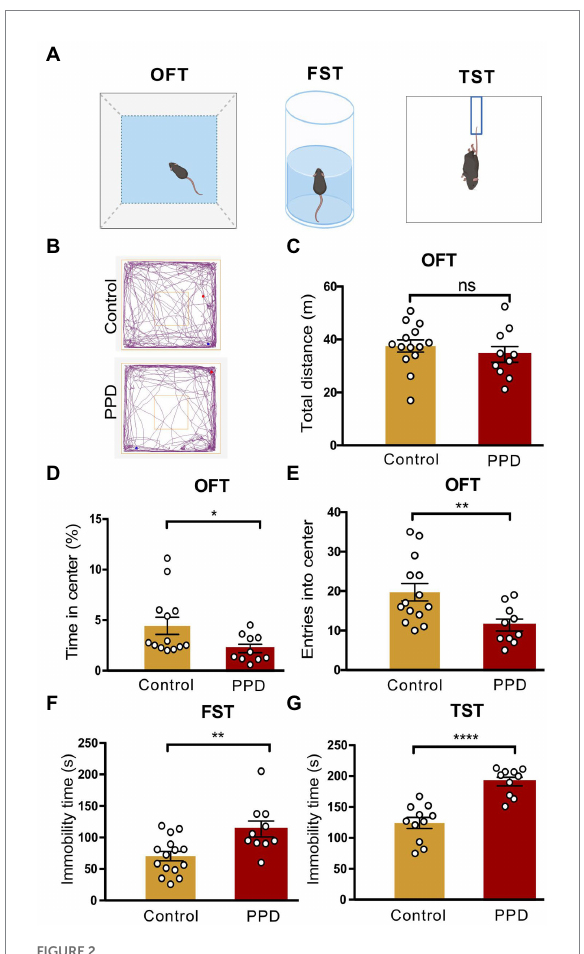
FIGURE 2 Gestational stress induced anxiety and depressive-like behaviors during the postpartum period. (A) The schematic diagram of the OFT, FST, and TST. (B) The representative movement tracks of each group. (C–E) Histograms showing the total distance traveled, time spent in the center, and number of entries into the center zone during the OFT. (F) Histogram showing the immobility time of mice in the FST. (G) Histogram showing the immobility time of mice in the TST. Data were mean ± SEM. White circles represent individual data points. * p < 0.05; ** p < 0.01; **** p < 0.0001 vs. Con; ns, not significant (unpaired t